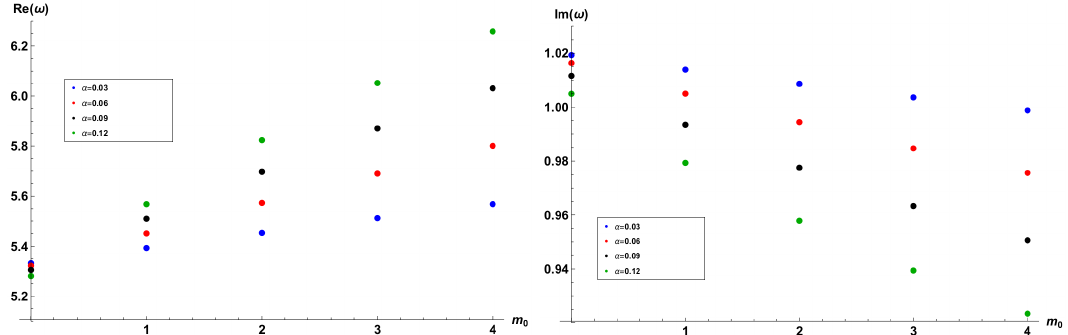
Figure 2 . Quasinormal modes of the accelerating Schwarzschild AdS black hole for r h = 1 and different m 0 . Each eigenvalue λ is given in table 8 of appendix B and corresponds to the fifth angular eigenvalue ( ‘ = 4 ) of each case.